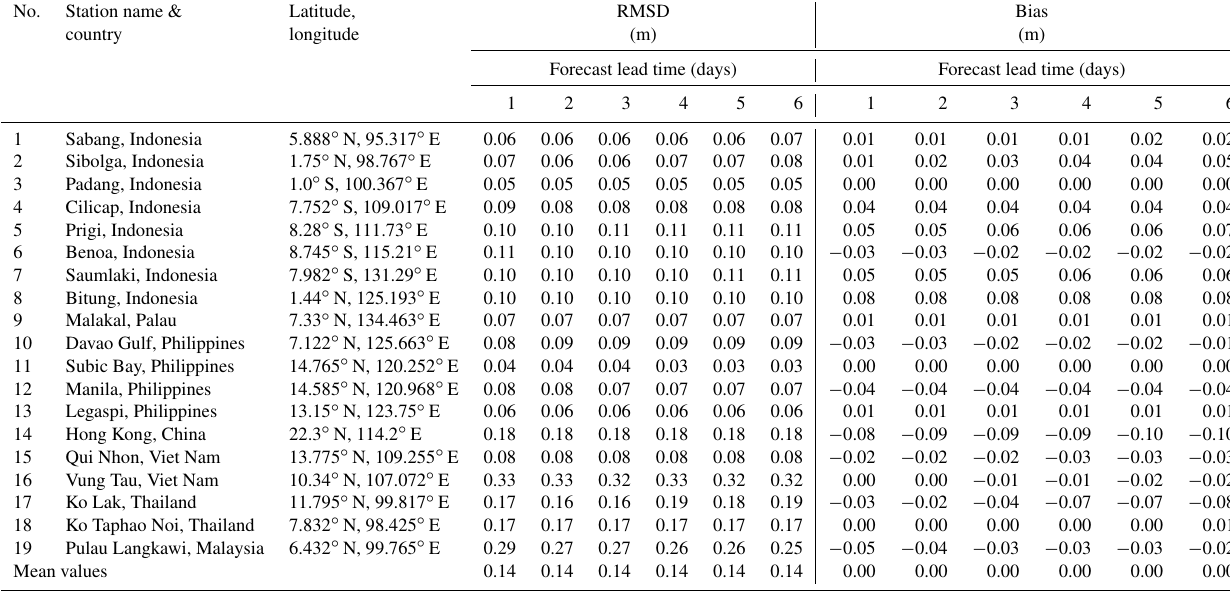
Table 7. Summary of SSH RMSD and bias statistics between coupled ocean forecasts and tide gauge observations during October 2019. Hourly instantaneous SSH from the model and observations is used for the